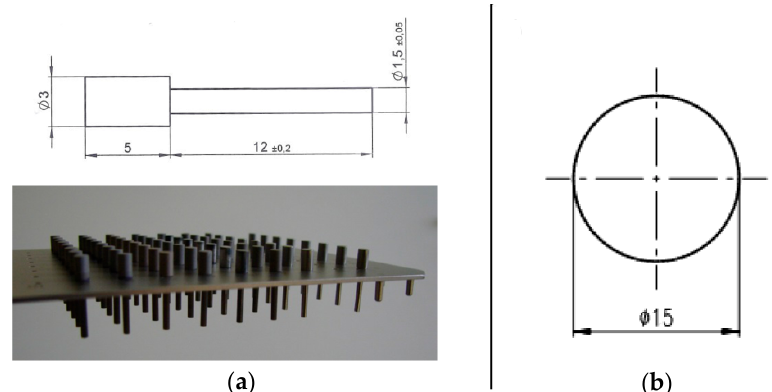
Figure 1. ( a ) Customized holding device and geometrical dimensions of the cylindrical samples used in the proliferation assay; ( b ) design of the disc shape samples used in the cytotoxicity tests.